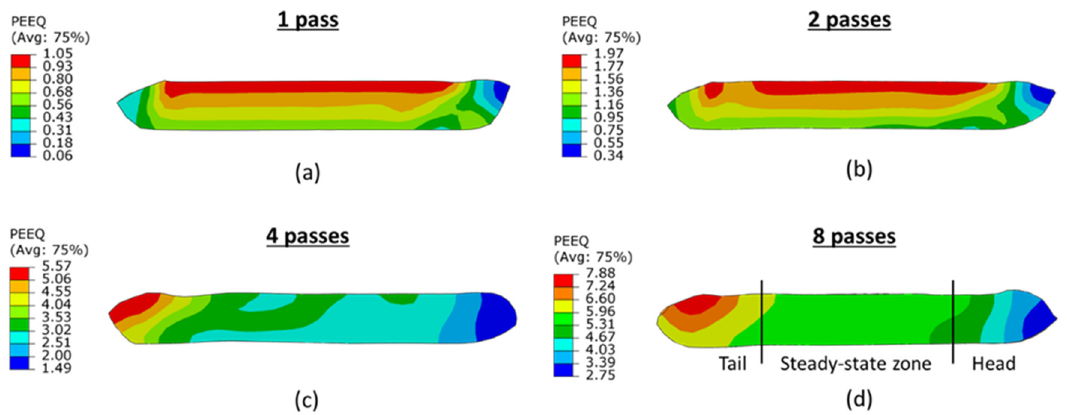
Figure 12. Equivalent plastic strain distribution contours along the length of the workpiece through ECAP for ( a ) 1 pass, ( b ) 2 passes, ( c ) 4 passes and ( d ) 8 passes.